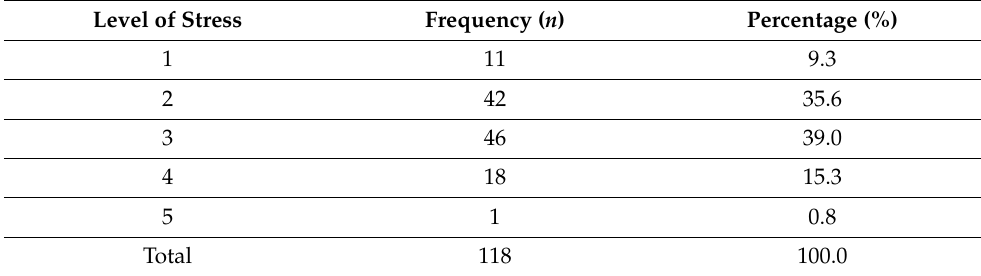
Table 2. How would you rate the level of stress experienced when working with SARS-CoV-2 infected persons on a scale of 1 to